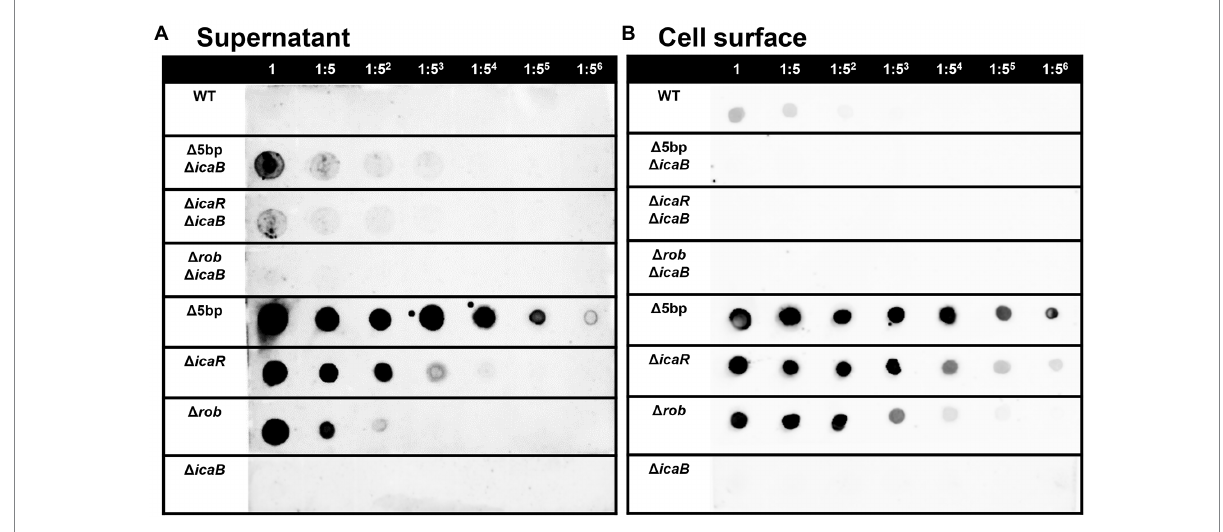
FIGURE 5 PIA / PNAG production on the culture supernatant and cell surface in each strain. PIA/PNAG production in the culture supernatant and on cell surface of the mutants. PIA/PNAG collected from the culture supernatant and cell surface of FK300 and FK300 Δ 5bp Δ icaB , FK300 Δ icaR Δ icaB ,